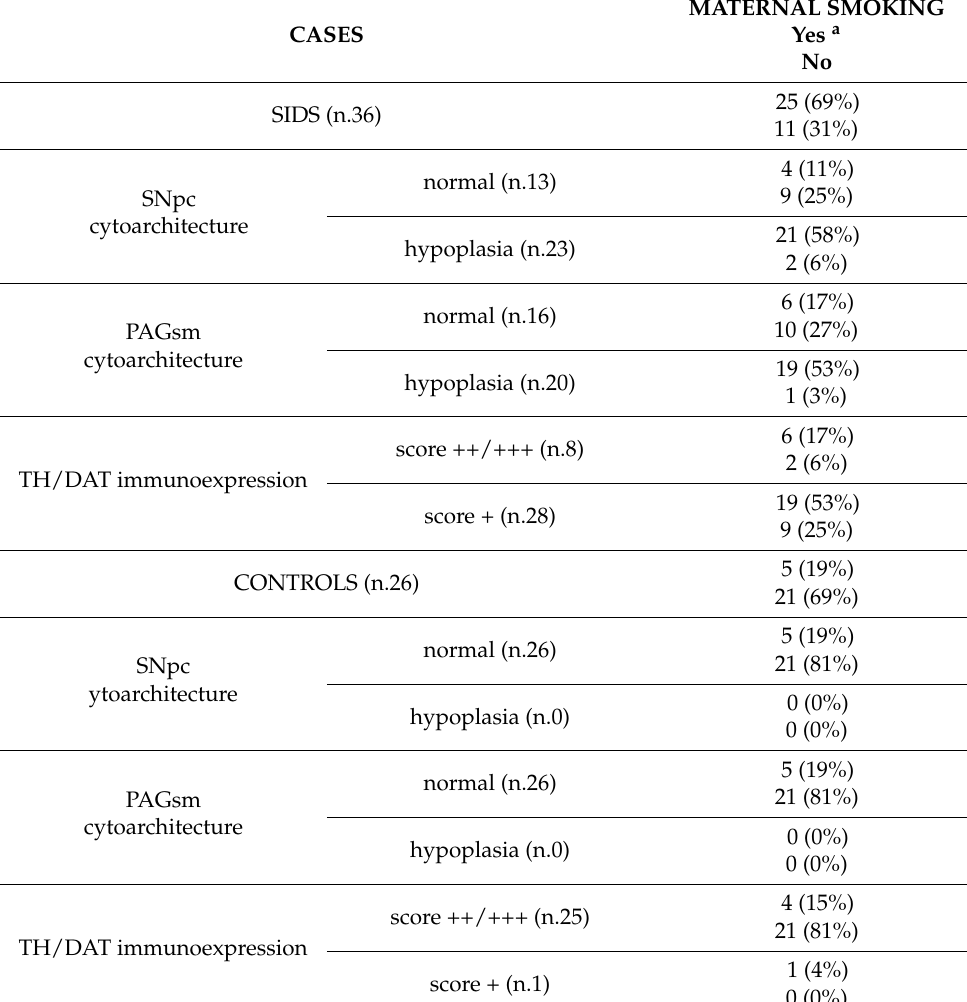
Table 3. Correlation of results with maternal